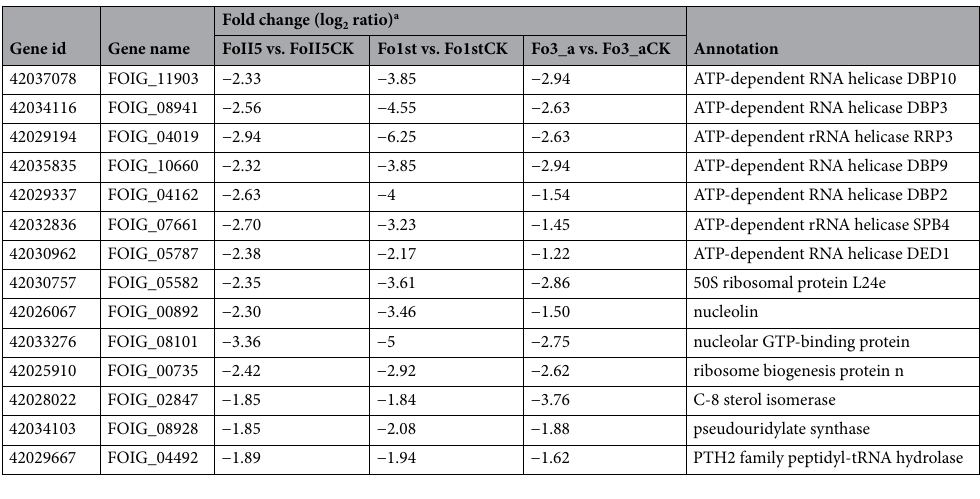
Table 3. The DEGs involved in fungicidal activity of phenamacril in Fo. a ‘CK’ represents the control groups treated with 0.1 μL/mL methanol and others represent the treatment groups treated with 1 μg/mL